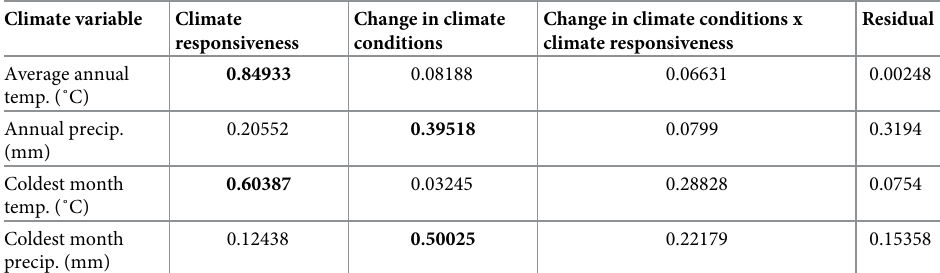
Table 2. Role of climate responsiveness v. rate of climate